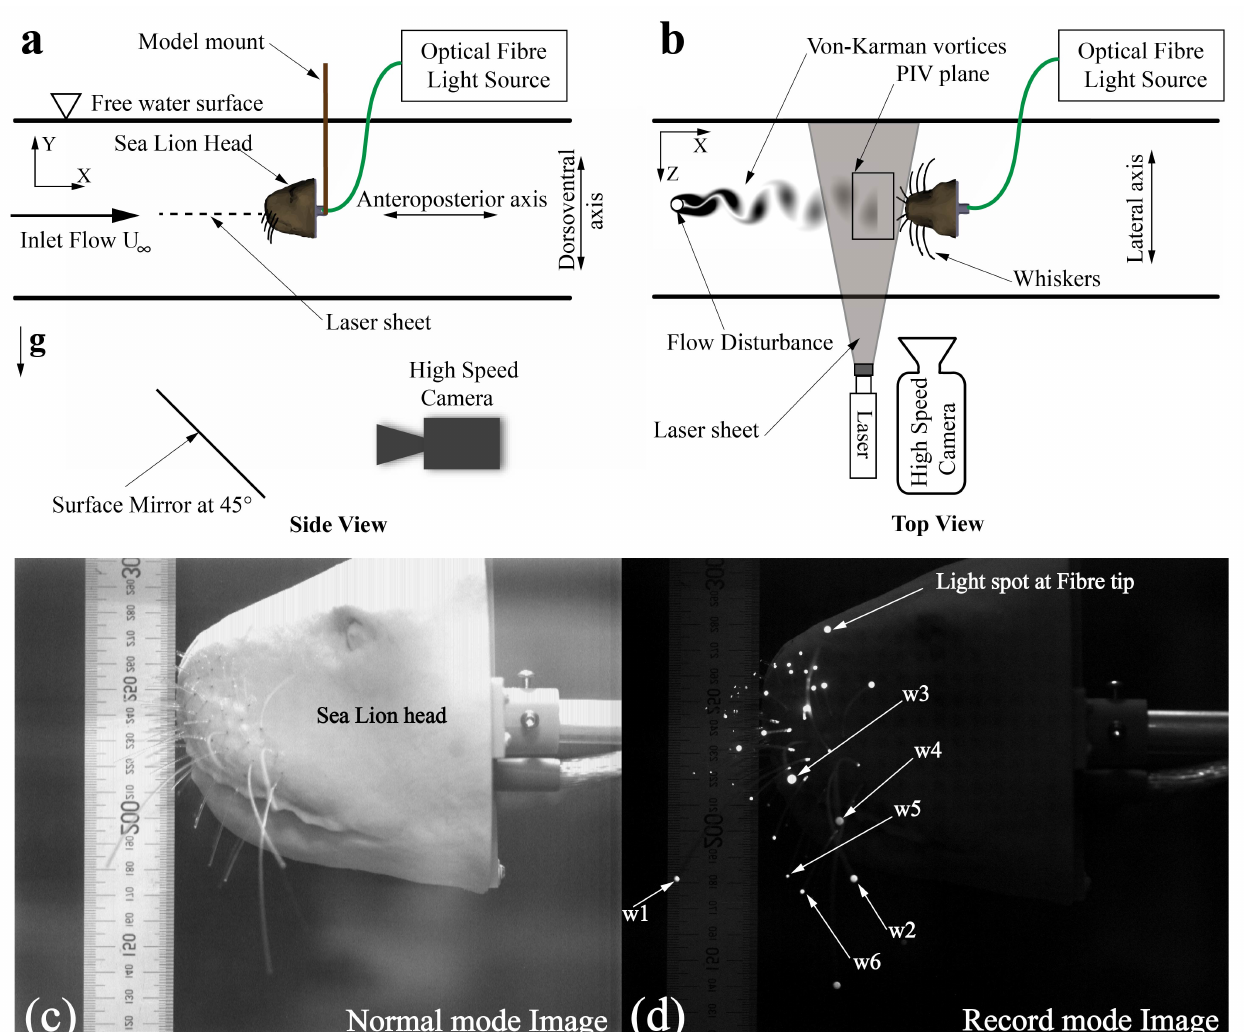
Figure 1. Schematic diagram of the experimental set-up, modified after [7]. ( a ) Side-view ( b ) Top-view. Von-Karman vortex street is shown for representation. ( c ) Normal mode photograph of the model from the camera (Scale in mm). ( d ) Image from the camera with reduced light and fibre optic light switched ON (the tips of fibres are visible as light spot) Note that the whisker numbering is used in the discussion of